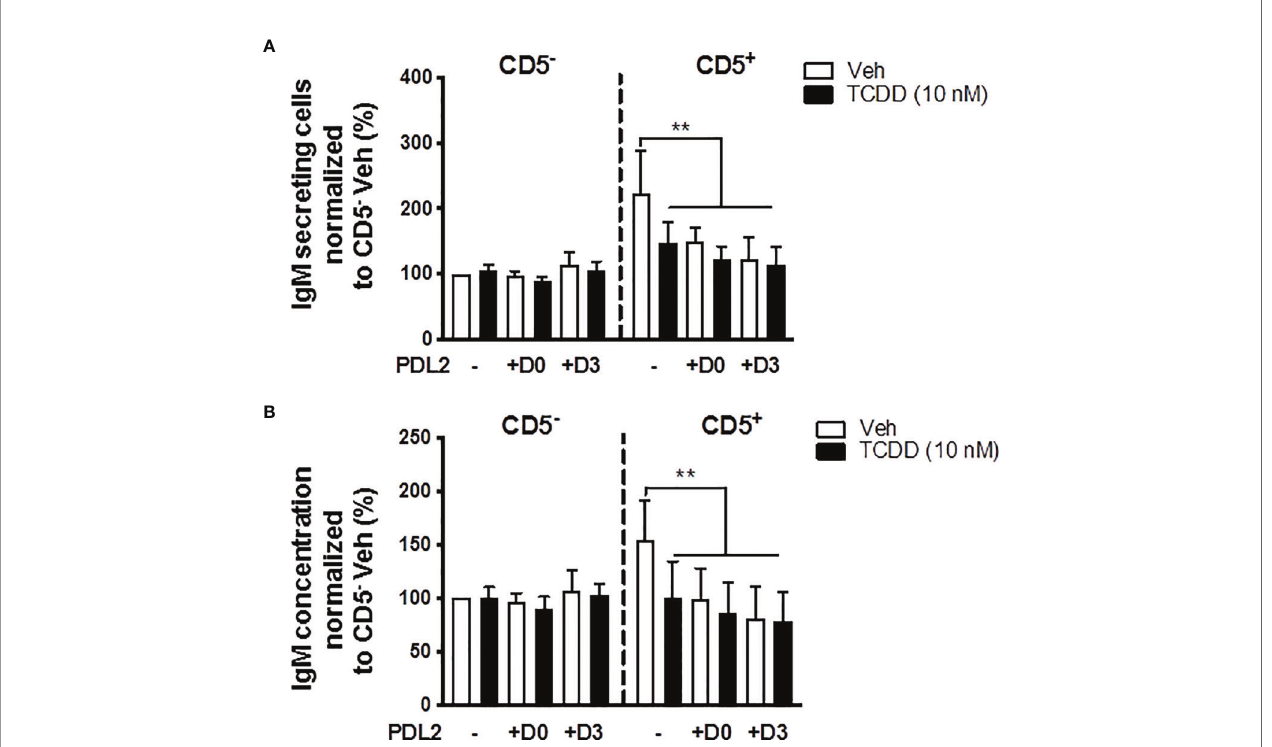
FIGURE 7 | Soluble PDL2 treatment did not further suppress the IgM response compared to AHR activation alone in CD5 + ILBs. Human CD5 +/- B cells activated as described were treated with Veh or TCDD in the presence or absence of soluble PD-L2. Soluble PDL2 was added to the culture on day 0 or day 3. (A) Averaged number of IgM secreting cells; and (B) Averaged IgM concentrations from CD5 +/- culture supernatants on day 7. Determinations were made using B cells from 6 human donors (N = 6). Data presented in the fi gure were normalized to Veh treated CD5 - B cells without PDL2 treatment. Signi fi cant differences are indicated by ** p < 0.01 (two- way ANOVA following with Fisher ’ s LSD post hoc